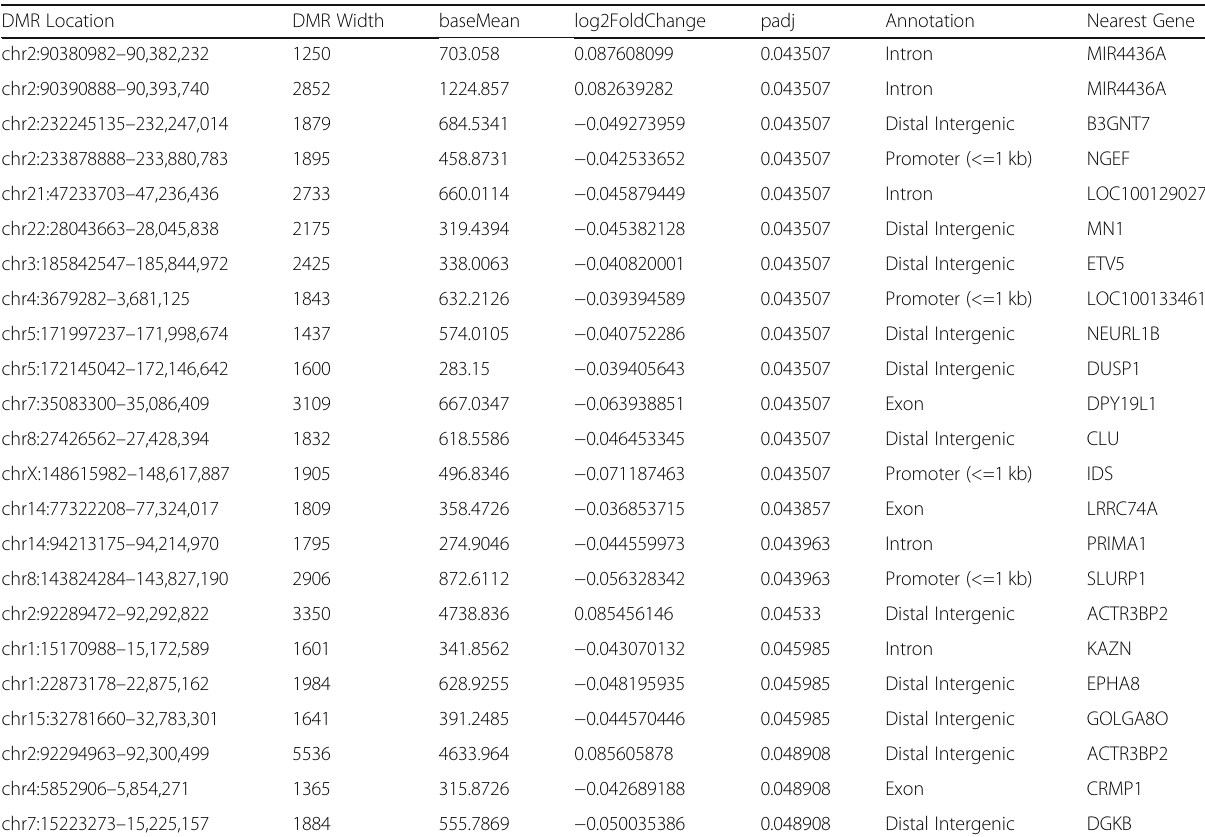
Table 3 Annotated DMR ’ s Associated with Gestational Age (Continued) DMR Location DMR Width